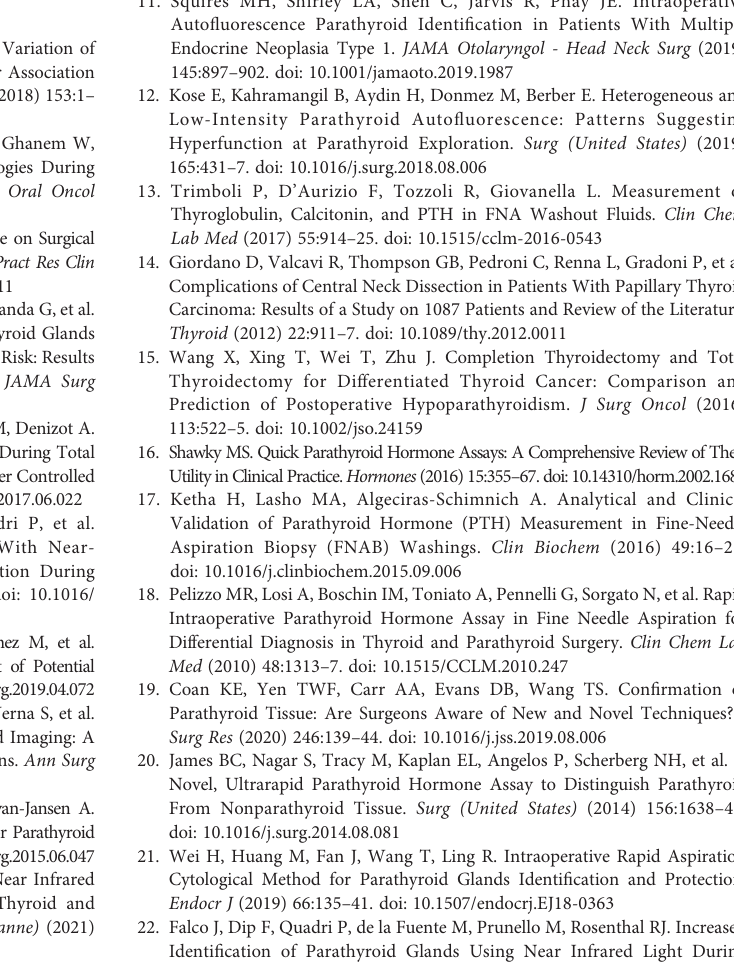
Supplementary Table 1 | Comparing the sensitivity and accuracy of NIRAF with visioninidentifyingparathyroidglands.PGsparathyroidglands; a ThesensitivityofNIRAF was signi fi cantly higher than vision in 596 parathyroid glands, P <.001. b The accuracy of NIRAF was signi fi cantly higher than vision in 841 suspected parathyroid tissues. P <.001 Supplementary Table 2 | Paired-samples t-test of fl uorescence intensity in different tissues. Supplementary Figure 1 | Fluorescence imaging device and operating environment. The operating room illuminated by LED light sources does